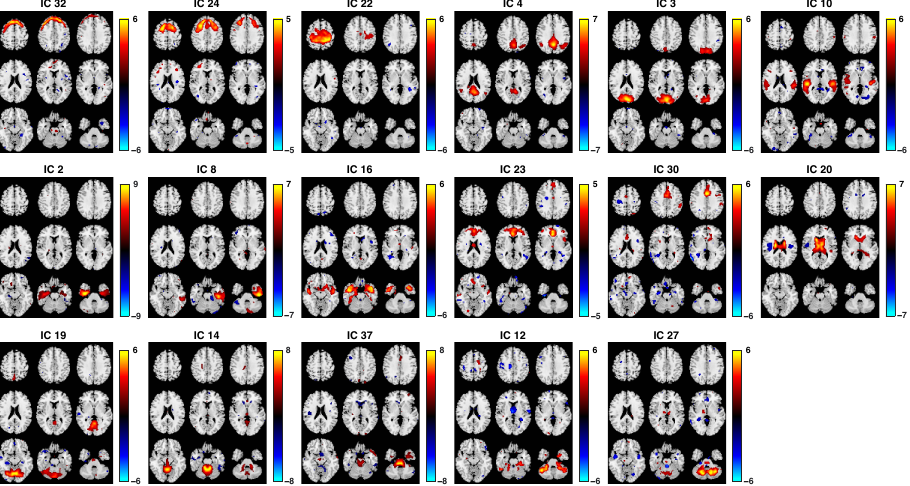
Figure 6. Spatial maps of 17 retained ICs from the fALFF dataset. These results reflect the IC results of SZ and HC groups combined. The brain maps are visualized at red color and negative Z values in